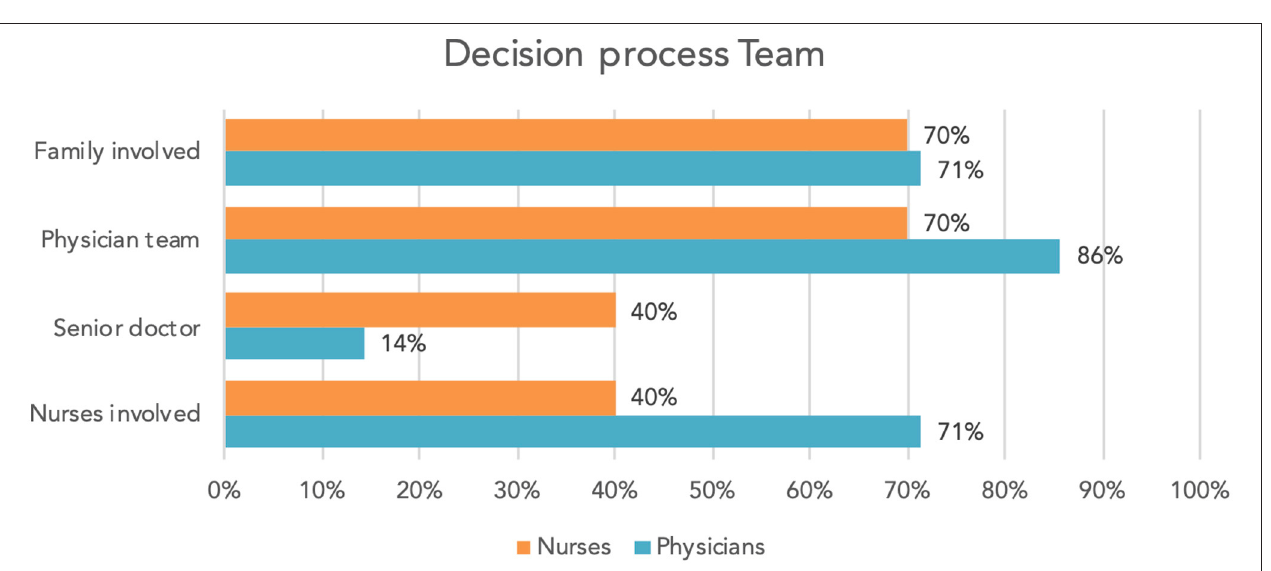
FIGURE 4 | Decision process: “How are decisions about limiting LST